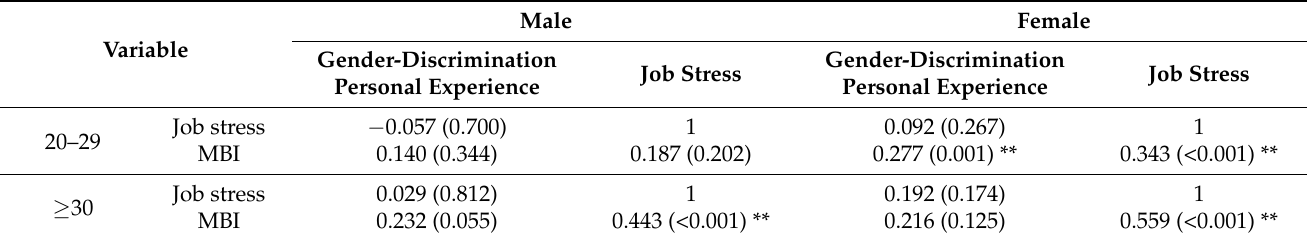
Table 3. Correlation of the gender-discrimination personal experience, job stress, and MBI.